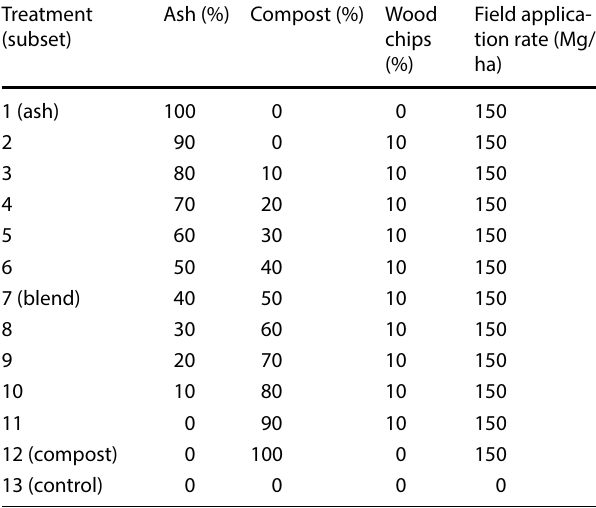
Table 1 Amendment composition for all treatments ( n = 10) and treatment subsets ( n = 3) used for growth experiment Treatment